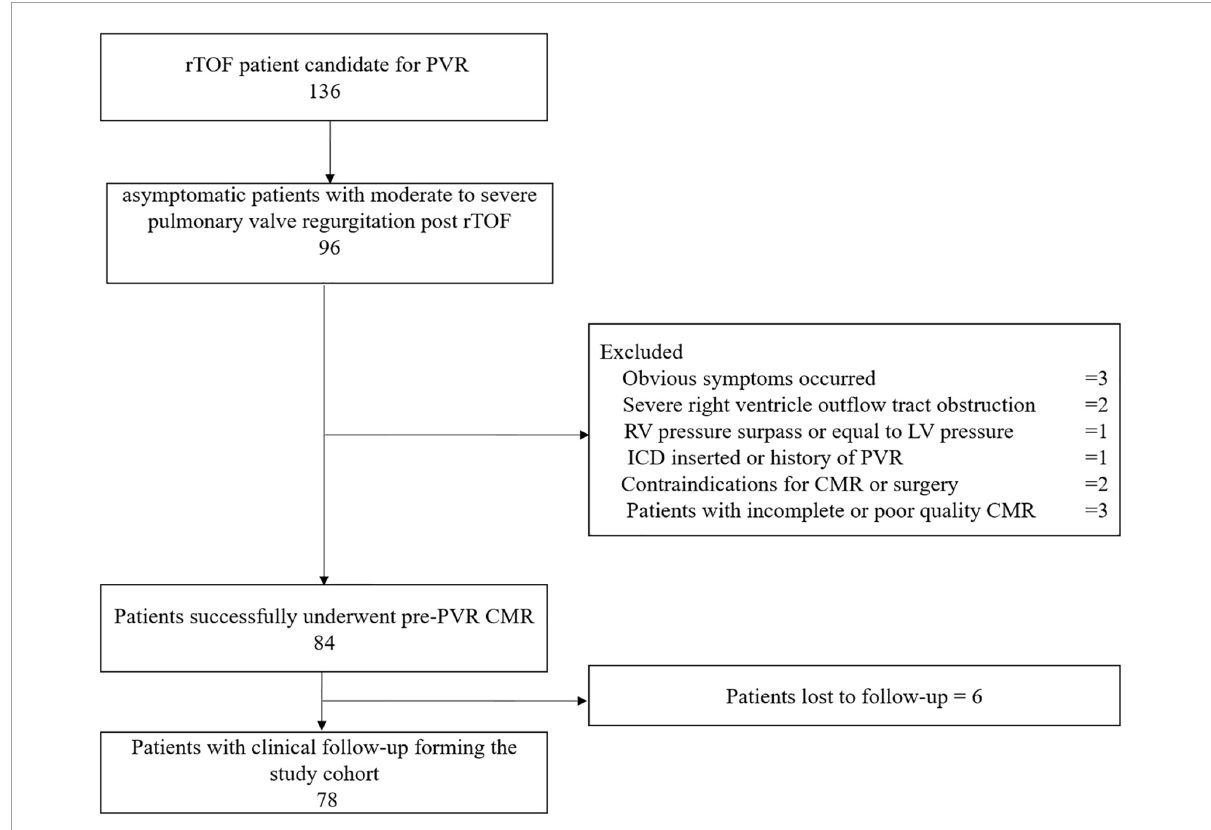
FIGURE2 This flow chart shows the number of patients at each stage of the study. PVR, pulmonary valve replacement; ICD, implantable cardioverter defibrillator; ToF, Tetralogy of Fallot; CMR, cardiac magnetic